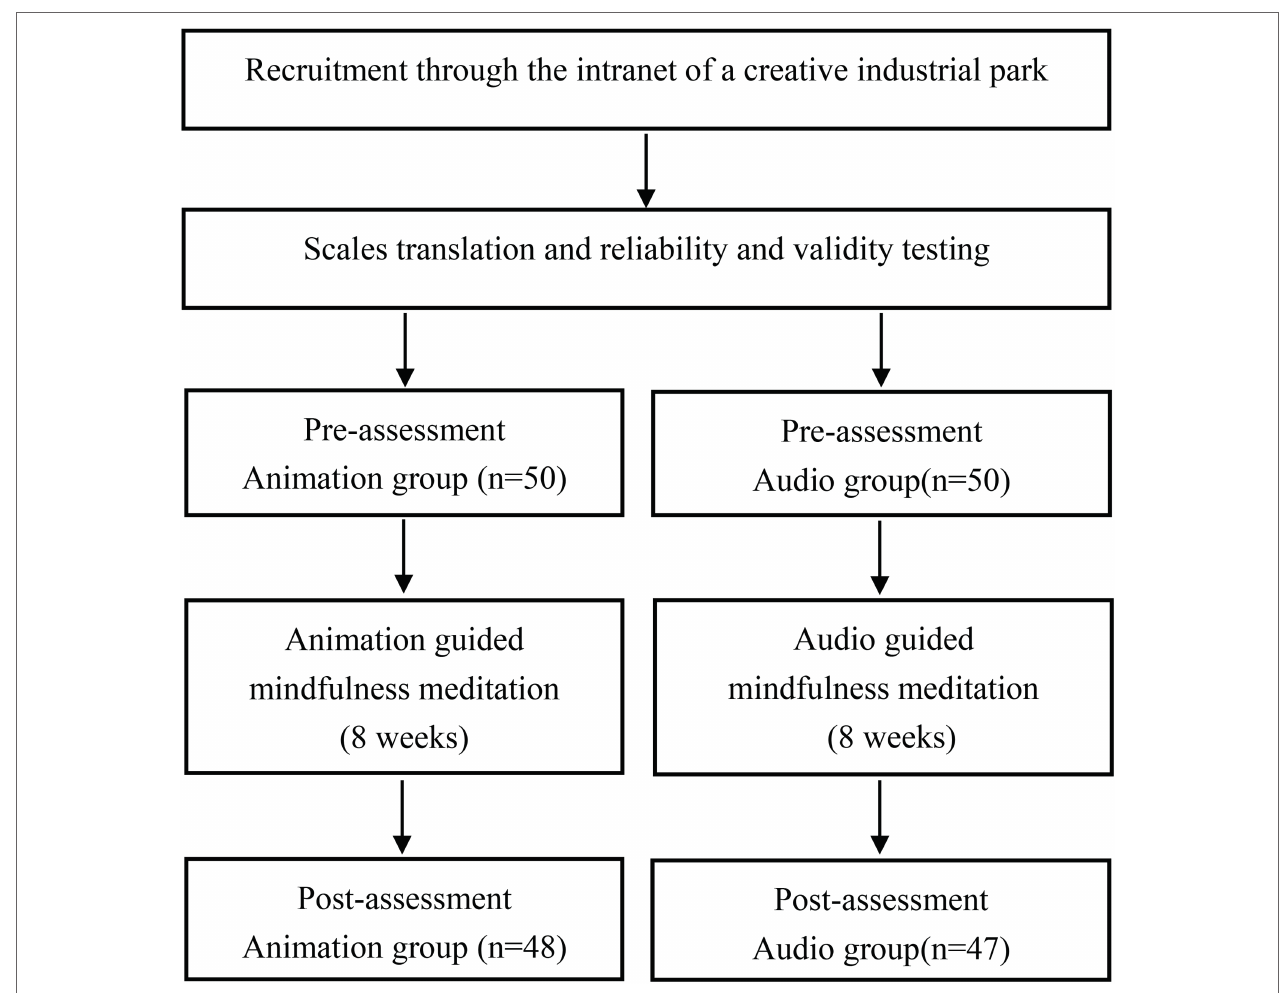
FIGURE 2 | Procedure flow chart.